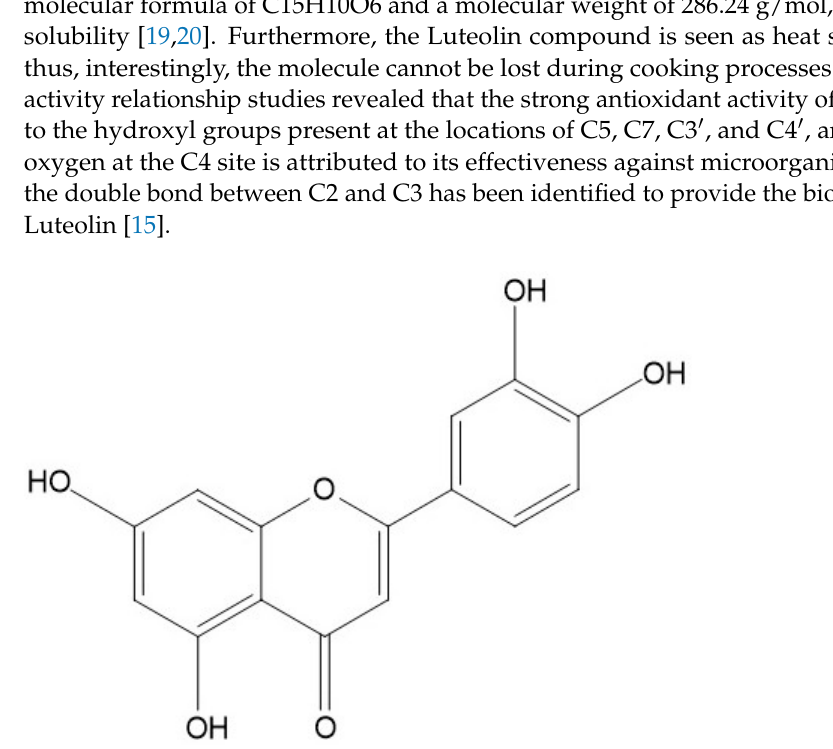
Figure 1. The chemical structure of